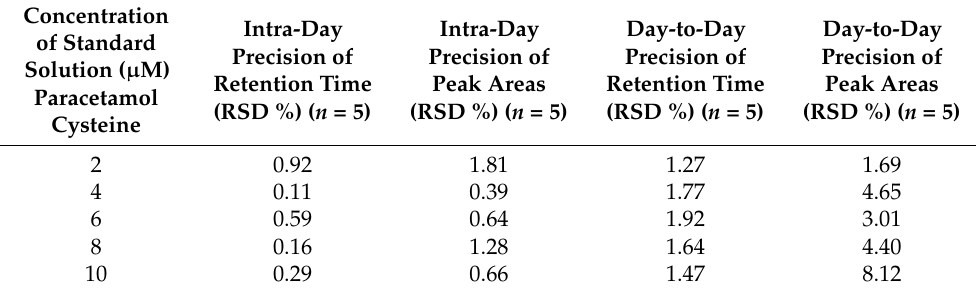
Table A4. Within-day and day-to-day precision of retention time and peak areas of paracetamol cysteine standard solutions in drug-free intestinal perfusate.